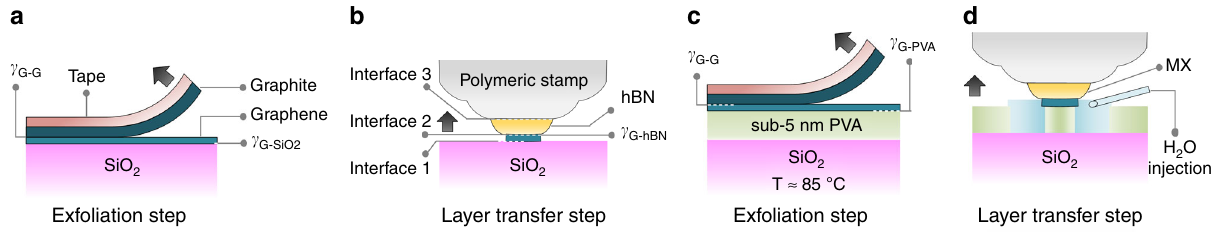
Fig. 1 Fabrication of vdW heterostructures. Schematic representations of a exfoliation and b layer transfer processing steps in the conventional fabrication methods. In those methods, γ G-SiO2 must exceed γ G-G during exfoliation. Moreover, γ G-hBN must exceed γ G-SiO2 during layer transfer. γ denotes the adhesion energy at the interface between two respective materials in contact with each other. These requirements are con fl icting, thus complicating the process of heterostructure fabrication. We introduce a simple interface engineering method to overcome this dilemma by using a nanoscale PVA release layer. c In our process, PVA can be tuned to promote exfoliation. d Moreover, selective removal of PVA enables a high-yield layer transfer of the exfoliated fl akes without requiring a specialized stamp, hence relaxing the choice of the stamp material (i.e., MX). The black arrows indicate the direction of the applied displacement force during the exfoliation and layer transfer